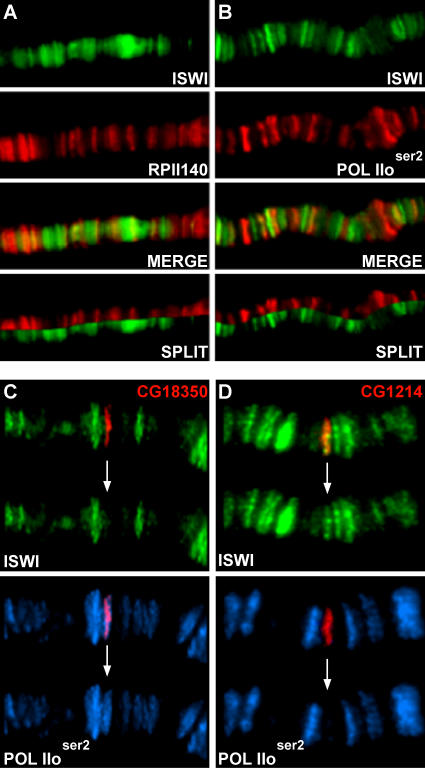
ISWI Plays a Relatively Global Role in Transcriptional Activation and Repression In Vivo(A and B) ISWI is associated with hundreds of euchromatic sites in a pattern that is largely complementary to that of Pol II. (A) ISWI (green) and Pol II (red) were detected using antibodies against ISWI and the second largest subunit of Pol II (RPII140). The distributions of ISWI and RPII140 are largely nonoverlapping, as observed in the split image. (B) ISWI (green) and elongating Pol II (red) were detected using antibodies against ISWI and the antibodies against Pol II hyperphosphorylated on Ser2 of the CTD (Pol IIoser2). Very little overlap is observed between ISWI and elongating Pol II, as observed in the split image.(C and D) Analysis of physical interactions between ISWI and its potential target genes in polytene chromosomes by immuno-FISH. Wild-type polytene chromosomes were stained with antibodies against ISWI (green) and the elongating form of Pol II (Pol IIoser2) (blue). FISH analysis identifies the locus of genes CG18350/Sxl (C) and CG1214/ru (D) in red. CG18350, which is expressed at reduced levels in Iswi mutants, localizes with Pol IIoser2 but does not co-localize with ISWI, as indicated by the arrows. CG1214, which is expressed at elevated levels in Iswi mutants, co-localizes with ISWI but not with Pol IIoser2, as indicated by the arrows.